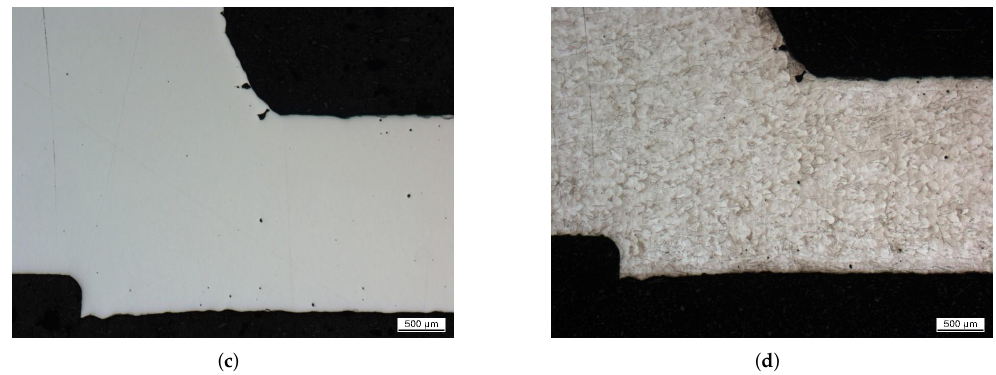
Figure 5. Cross sections of printed KF40 pipe. ( a ) material homogeneity of the pipe wall (untreated cut); ( b ) material structure of the pipe wall (etched cut); ( c ) material homogeneity of the flange overhang (untreated cut); ( d ) material structure of the flange overhang (etched cut) Courtesy of GSI Darmstadt, pLinac project.